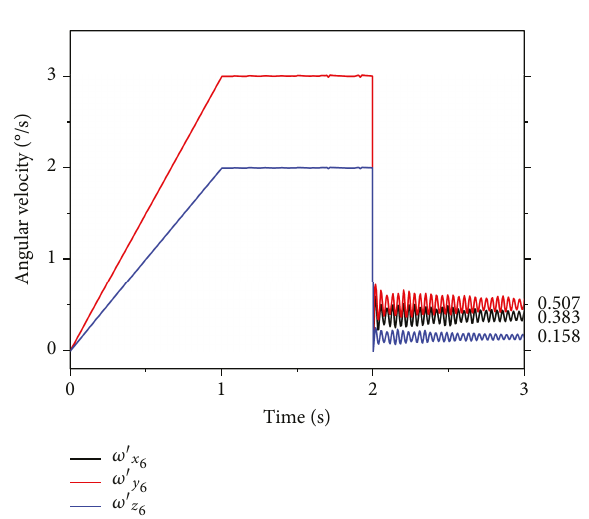
Figure 20: Simulation results of liquid storage tank and microsatellite with the deployment mechanism for ω xf